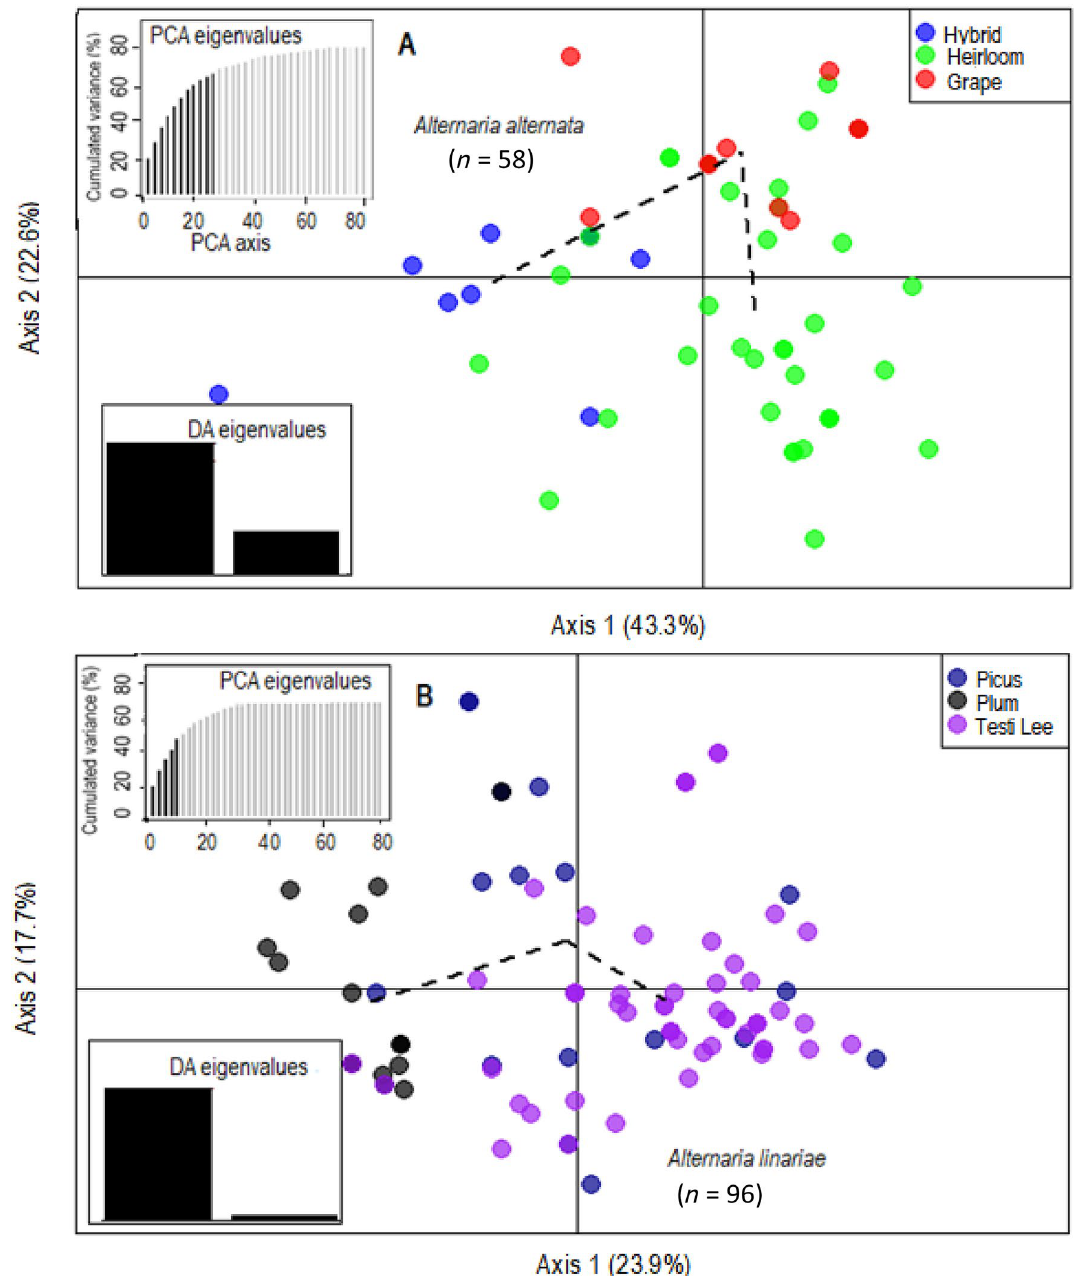
Figure 4. Discriminant analysis of principal components (DAPC) model showing clustering of tomato variety populations using 220 single nucleotide polymorphisms (SNPs) from 10 microsatellite loci. For A . alternata ( A ), alleles contributed more than 5% to the first principal component (Axis 1) and more than 5% to the second principal component (Axis 2). For A. linariae populations ( B ), alleles that contributed more than 5% to the first principal component (Axis 1) and more than 5% to the second principal component (Axis 2). Lines and shapes represent individual genotypes, colour-coded by their original host varieties, and surrounded by ellipses. Discriminant analysis (DA) and principal component analysis (PCA) eigenvalues represent the amount of genetic variation captured by the analysis. PCA eigenvalues are the cumulative variance explained by the retained principal components. DA eigenvalues represent which linear discriminants are compared in each scatter plot, with the height of each bar representing the relative contribution in explaining total